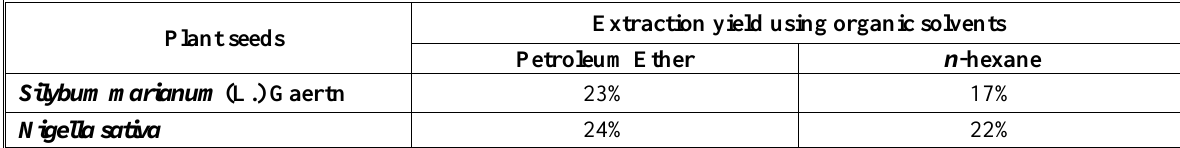
Table1: Oil yields obtained from extraction of Silybum marianum (L.) Gaertn, and Nigella sativa seeds using organic solvents petroleum ether and n -hexane